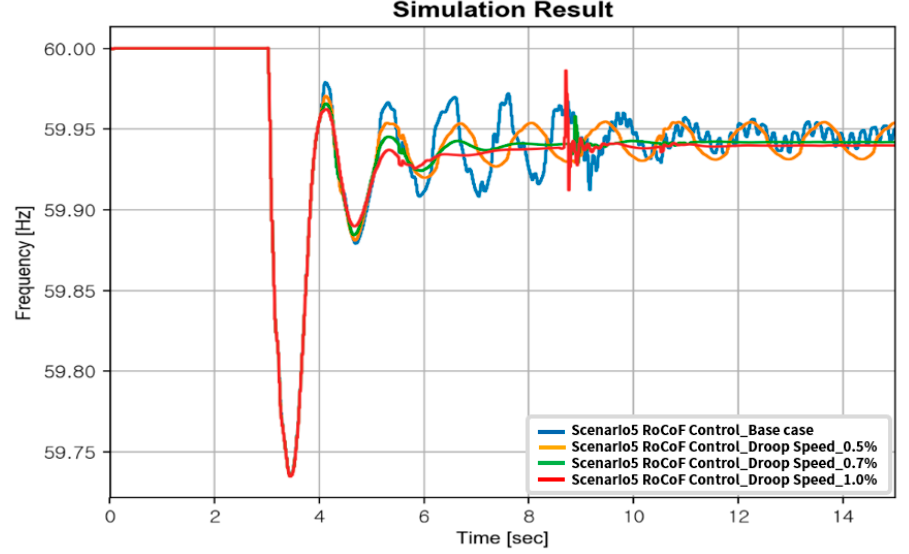
Figure A2. Frequency response by ESS parameter (droop speed). When system H increased, the minimum frequency increased as the ESS output power increased in the trans-state, but oscillation occurred, as in the result of the droop speed adjustment.